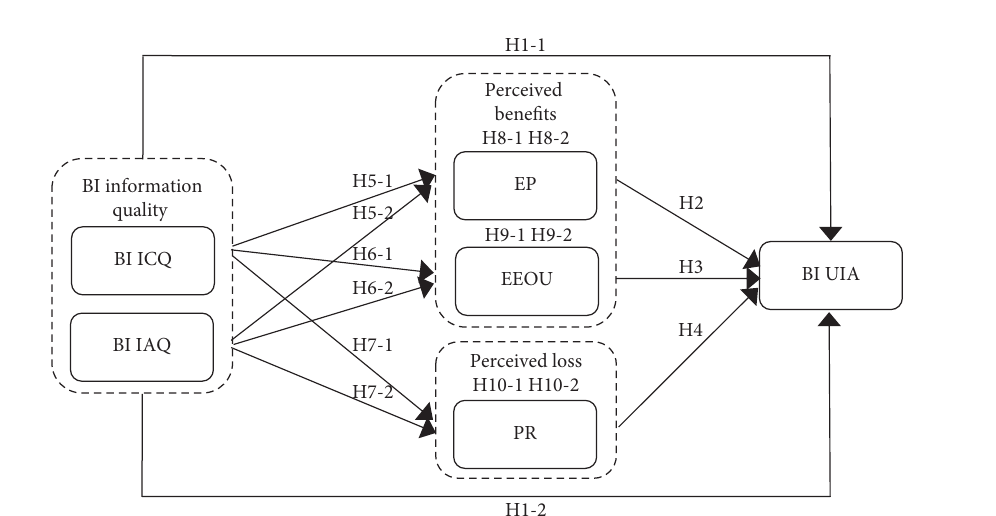
Figure 1: Model for the influence of BI information quality on UIA.